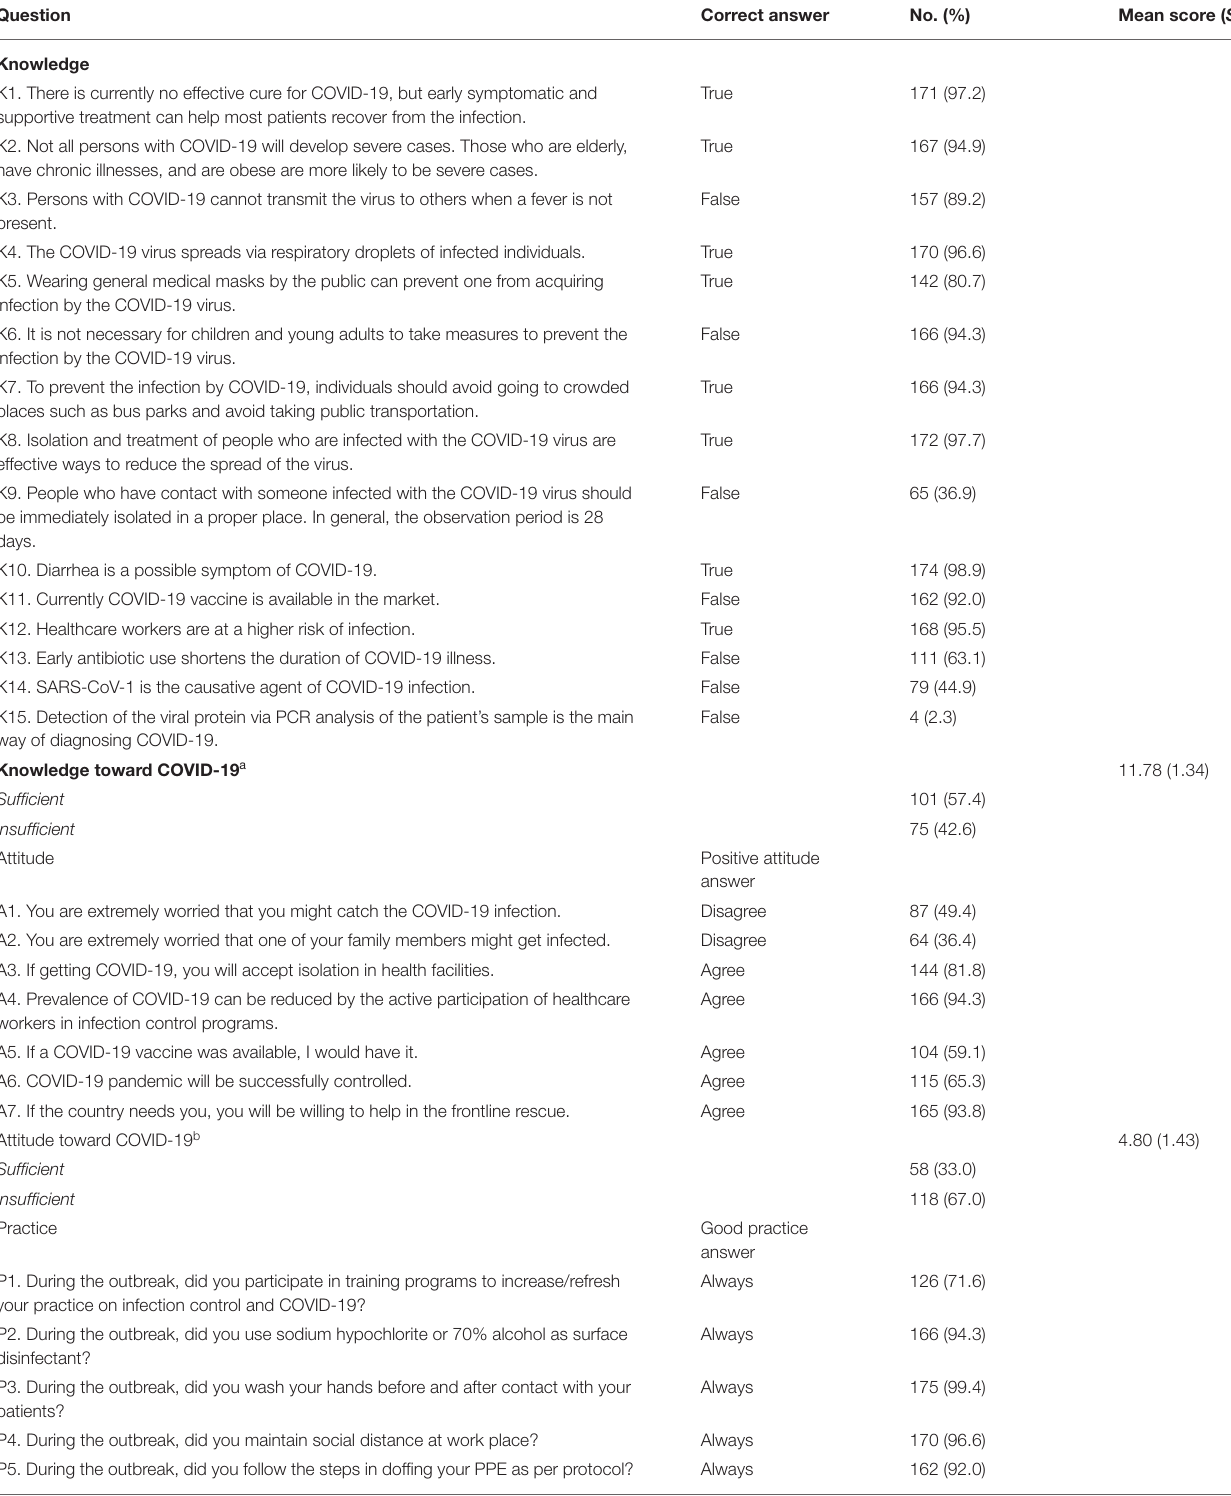
TABLE 2 | Knowledge, attitude, and practice scores of healthcare workers regarding COVID-19 ( n = 176). Question Correct